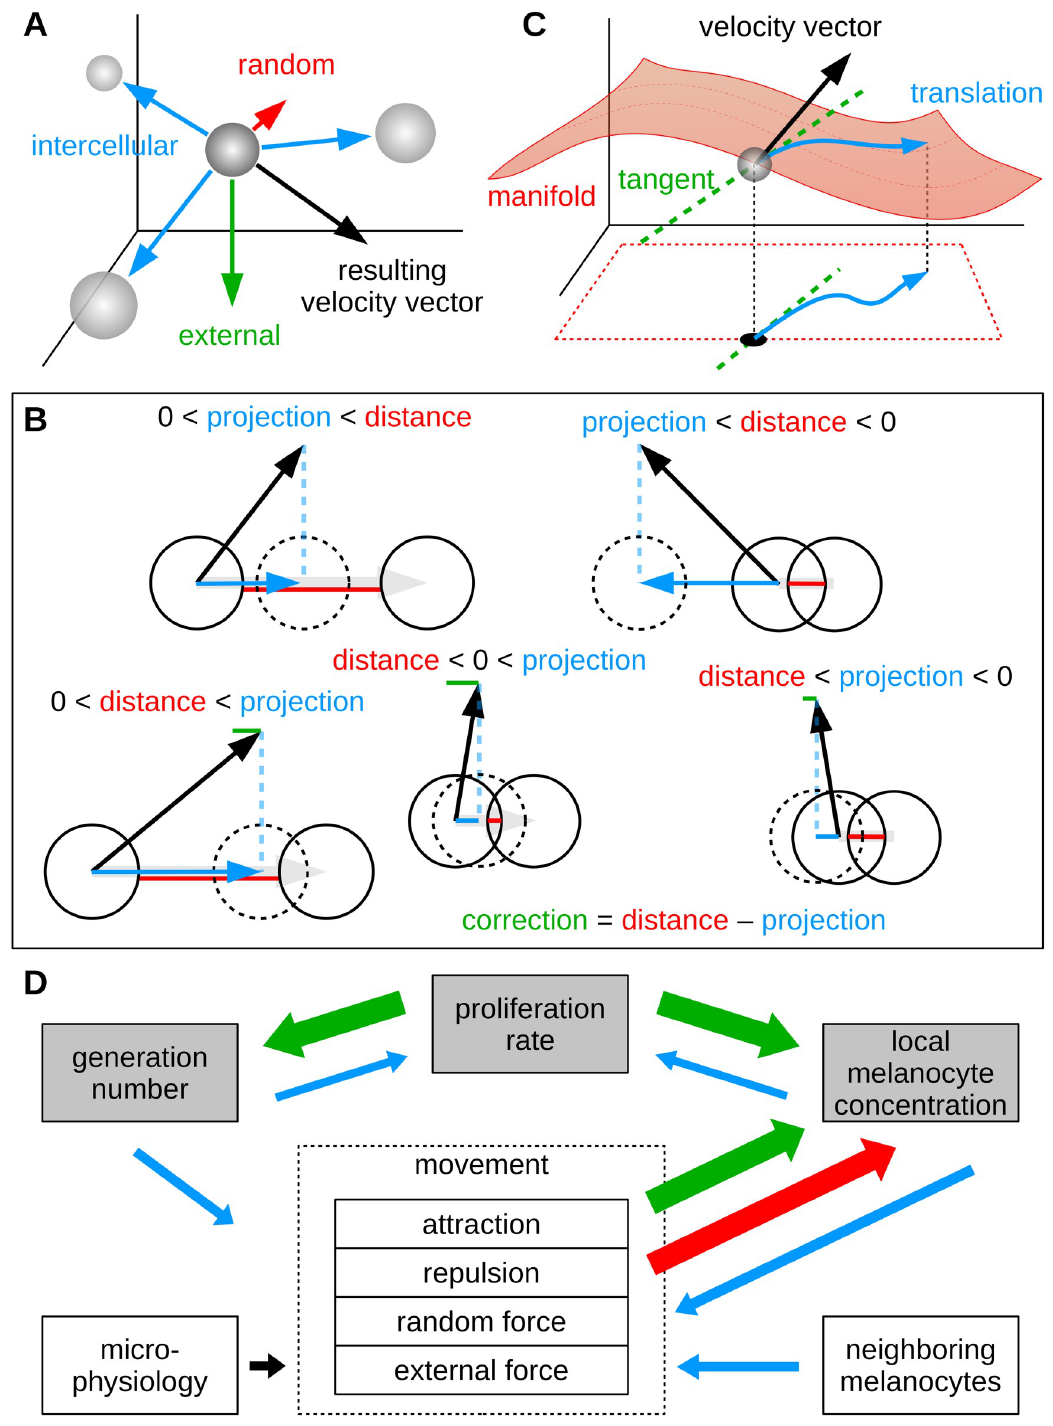
Fig 3. Schematic outline of the agent-based model. (A) Abstracted intercellular forces (attraction and repulsion), random forces and external forces impose a velocity vector on each individual cell. (B) To minimize the overlap of spherical cells, a simplistic corrector algorithm is applied on the resulting velocity vector (for clarity shown in two dimensions). In all cases where the anticipated new position of a cell results in overlap with a neighboring cell, a certain (projected) component of the velocity, which we call the correction, is subtracted from the vector. Due to iterative application, this procedure ensures that the total overlap of simulated cells is minimized. (C) The corrected three dimensional velocity vector is projected into the coordinate space of